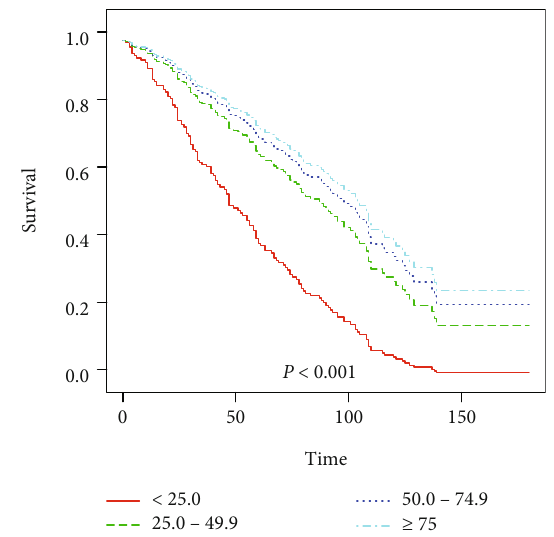
Figure 2: Kaplan – Meier survival analysis plot for all-cause mortality with serum 25(OH)D categories ( < 25.0, 25.0 to < 50, 50.0 to < 75, and ≥ 75nmol/l). DKD patients in 25 ð OH Þ D < 25 : 0 nmol/l had the highest probability of survival, and patients in 25 ð OH Þ D ≥ 75nmol/l had the lowest probability of